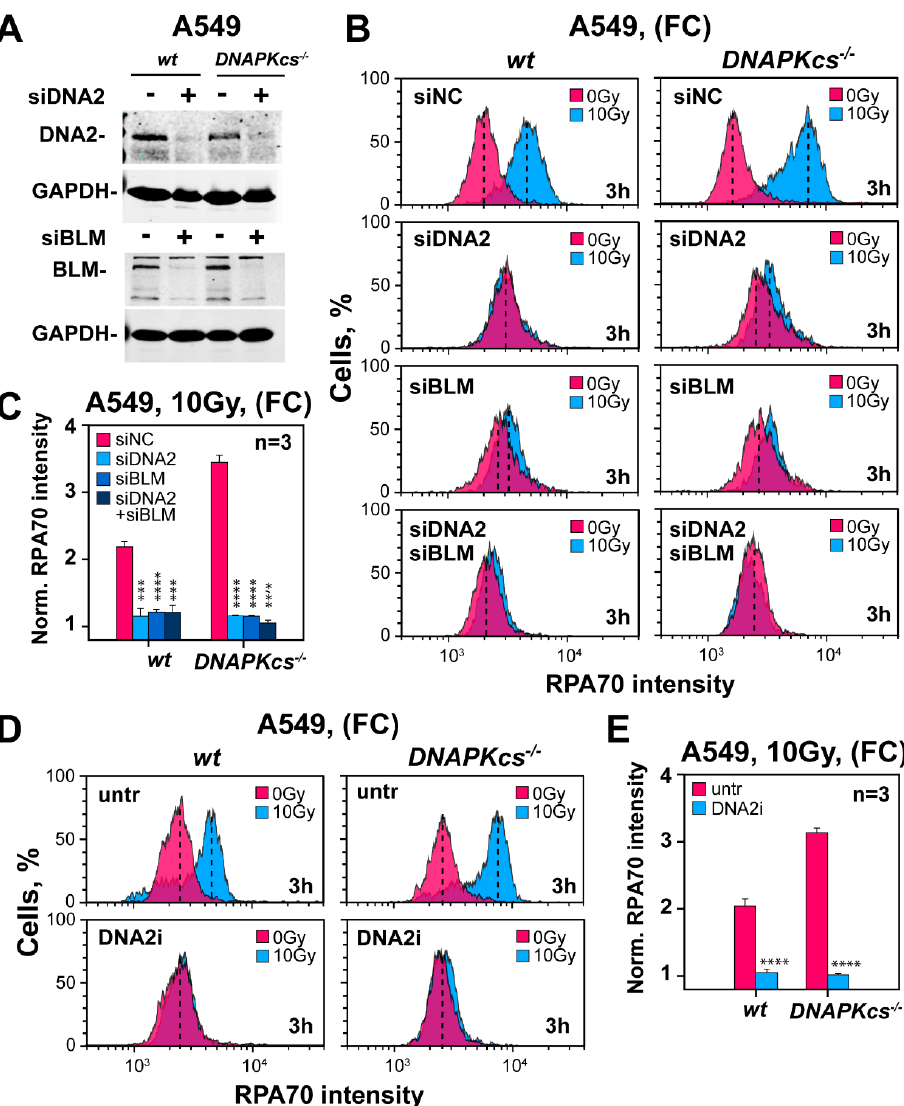
Figure 6. Depletion of DNA2/BLM nuclease-helicase complex suppresses resection in wt and DNA- PKcs − / − A549 cells. ( A ) Western blot analysis showing levels of DNA2 and BLM proteins after transfection of parental and DNA-PKcs − / − A549 cells with siRNAs targeting these proteins, or with a non-specific control siRNA. ( B ) As in Figure 1B for the conditions shown in panel ( A ) in cells exposed to 10 Gy of IR. ( C ) As in Figure 1C for the results in panel B. ( D ) As in panel ( B ), for A549 cells treated with 4 µM of a specific DNA2 inhibitor, (DNA2i). ( E ) As in panel C for the results in panel D. *** indicates p < 0.001 and **** indicates p < 0.0001.